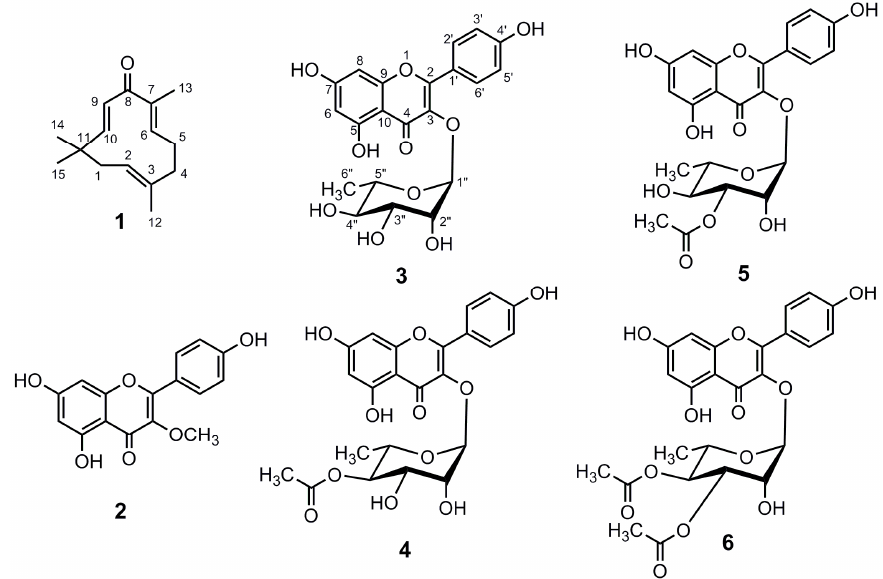
Figure 1. Schematic flowchart of extraction and isolation of compounds from the rhizomes of Zingiber montanum .